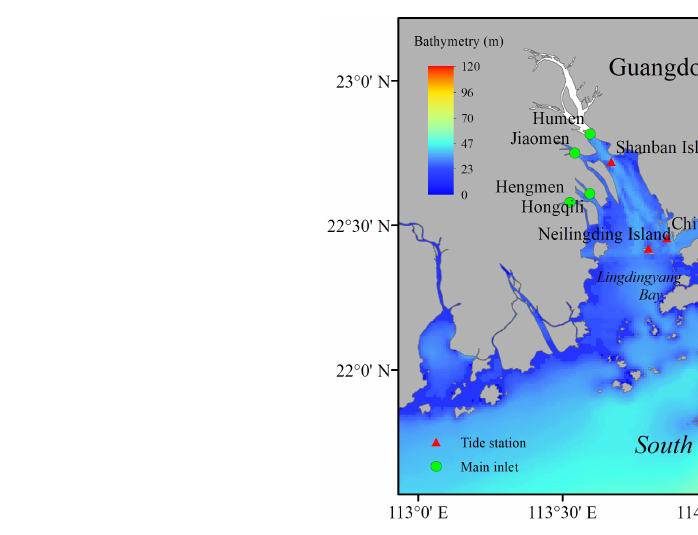
FIGURE 1 Study area and its bathymetric